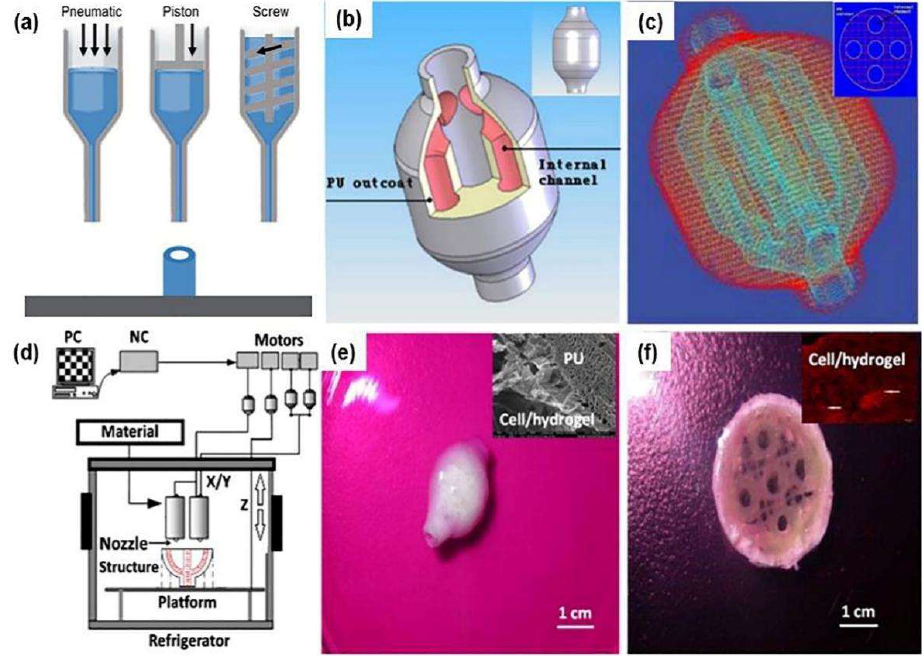
Figure 5. ( a ) Extrusion bioprinting nozzle (or syringe) systems (pneumatic, piston and screw). ( b ) A digital computer-aided design (CAD) model with an outlook and an internal branched network of the vascular networks. ( c ) A common layer interface (CLI) file. ( d ) Schematic illustration of the fabrication process of a layered vessel model using a dual-jet extrusion printer by Wang et al. ( e ) A